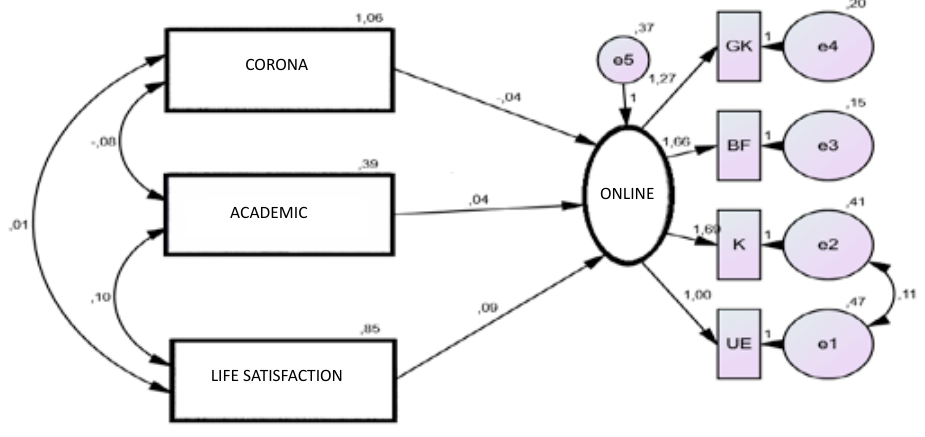
Figure 1. Path diagram regarding the prediction of online learning attitude